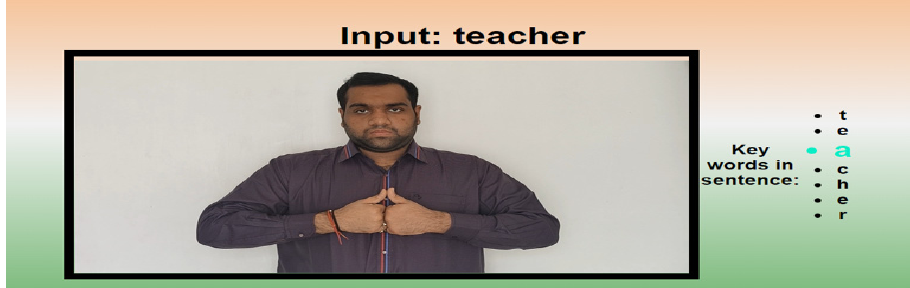
Figure 11. Case 3. Available video for letter ‘a’.